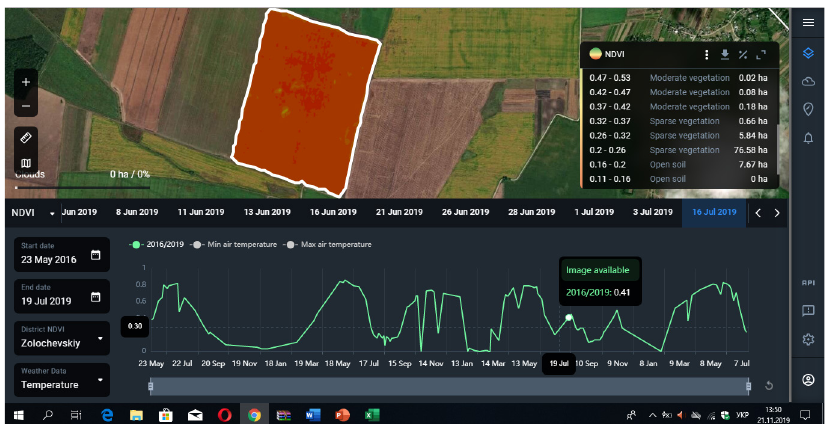
Figure 4. Image of the NDVI curve of annual flow for 2016–2019 and the state of land use according to the vegetation index as of June 28, 2019